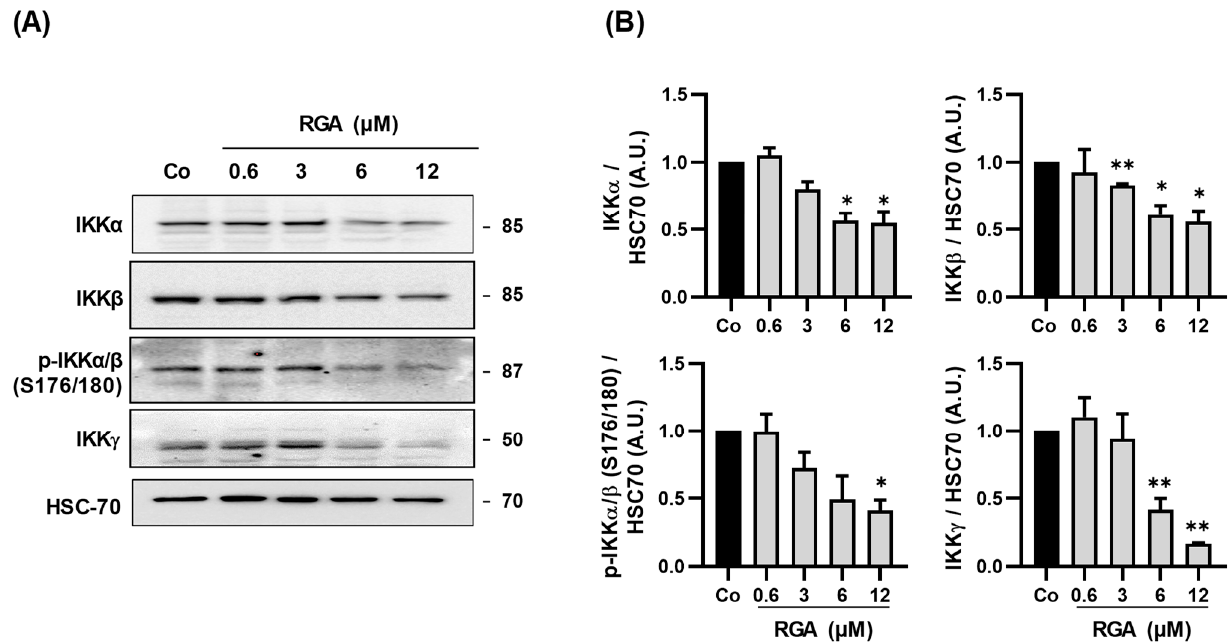
Figure 5. The RSV/ ω -3 fatty acids combination decreases subunits of I κ B complex protein expression. ( A ) Immunoblot analysis of IKK α , IKK β , phospho-IKK αβ (p-IKK αβ ), IKK γ in RGA-treated ARPE-19 cells with increasing concentrations (0.6, 3, 6, 12 µ M) or with vehicle (Co) for 24 h. HSC-70 was used as a loading control. ( B ) Densitometry quantification of western blotting. Data are expressed as the mean fold induction ± SEM of three independent experiments. p values were determined by a one-way ANOVA followed by Tukey’s multiple comparison test of treatments vs. control. * p < 0.05 and ** p < 0.01.